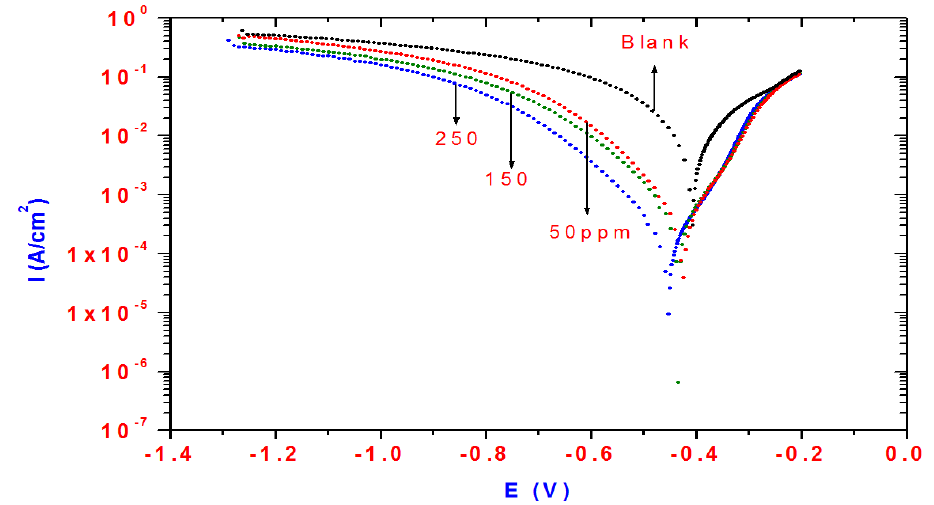
Figure 8. Polarization curves for steel in 1M HCl solution containing different concentrations of